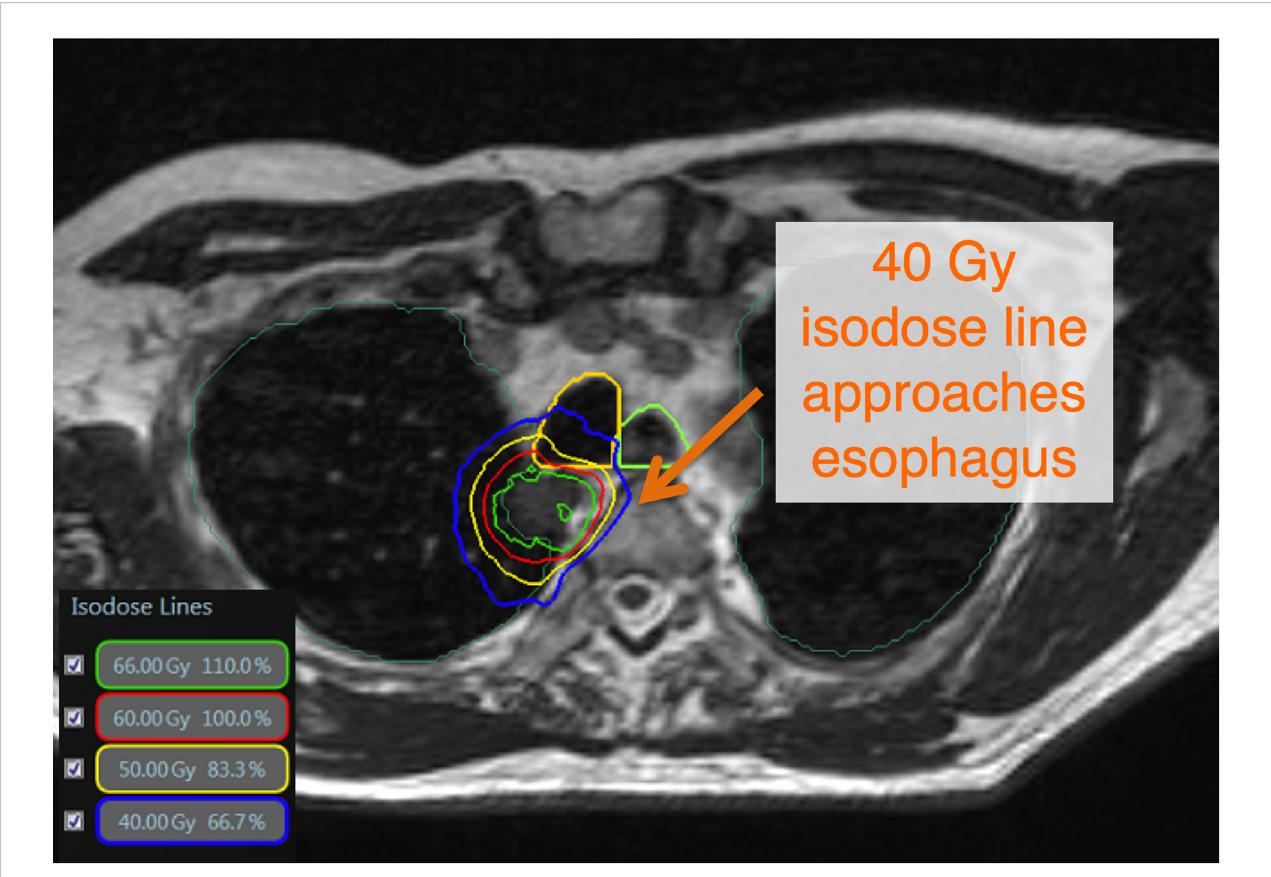
FIGURE 1 There is no consensus de fi nition of ultracentral lung tumors. The Nordic-HILUS trial de fi nes ultracentral targets as ≤ 1cm from the proximal bronchial tree, which is also used at our institution. These close tumors may lead to high dose to critical organs such as proximal airways and the esophagus. This is a TRUFI sequence on the MRIdian system showing an ultracentral tumor with doses approaching critical organs such as the esophagus and trachea